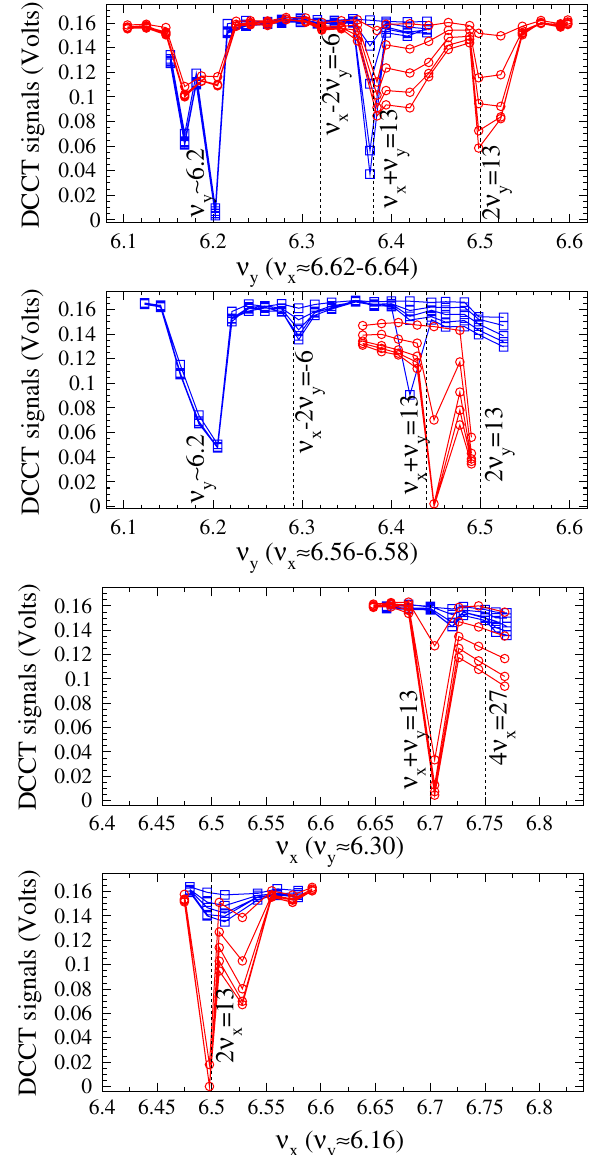
FIG. 15. (Color) Beam survival at 1, 5, 10, 15, and 19 ms as a function of the betatron tune, measured with DCCT in the 181 MeV beam storage mode, where the extraction DC magnets were excited at 3 GeV (red circles) or at 181 MeV (blue